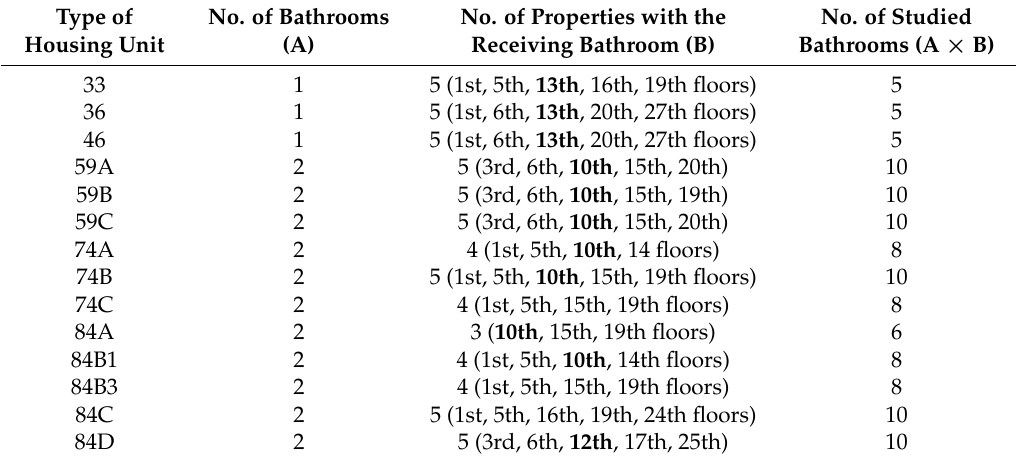
Table 5. The number of lower-floor bathrooms ( N = 113) and properties ( N = 64) studied. Type of